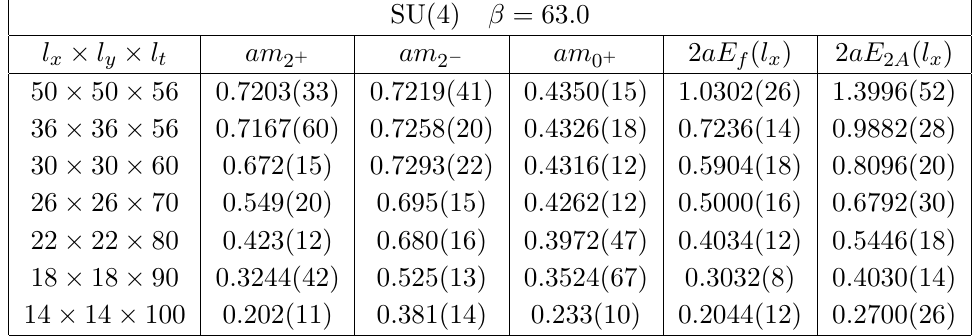
Table 4 . Lightest J P = 2 + ; 2 (cid:0) ; 0 + glueball masses on various l x (cid:2) l y spatial lattice volumes. Also twice the energy of the lightest fundamental, E f ( l x ), and k = 2, E 2 A ( l x ), (cid:13)ux tubes that wind around the spatial torus. In SU(4) at an inverse bare coupling (cid:12) = 8 =ag 2 = 63 : 0.